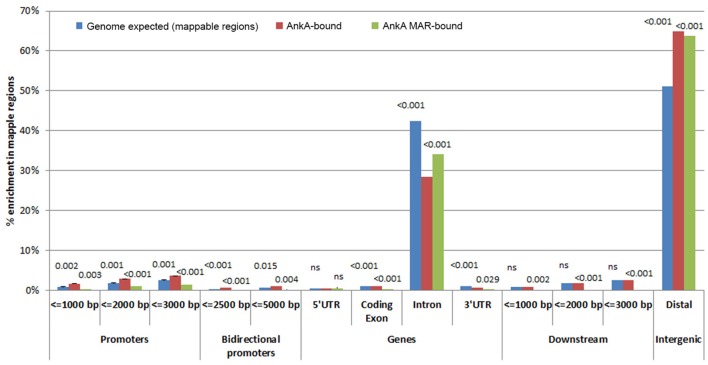
Relative AnkA enrichment compared to mappable regions in the chromosomes [genome background (blue)] for all AnkA-enriched sites (red) and AnkA-MAR-enriched sites (green). Promoter regions are shown as distance upstream of transcriptional start sites, genes are shown as 5′ untranslated regions (UTR), coding exons, introns, and 3′UTRs, downstream regions are shown as the distance from the transcription termination sites, and intergenic regions using CEAS. The height of the bars represents the average of 3 separate experiments using individual donor neutrophils, including error bars. Numbers above the bars represent p-values of the comparisons for genomic background vs. enrichment at all AnkA-binding sites (left number) and vs. enrichment of AnkA-bound MARs (right number); p < 0.0168 were considered significant. Compared to genomic background, AnkA is most significantly enriched in distal intergenic regions, including when bound to MARs. Similarly, but to a much lower degree, AnkA is more significantly bound to the promoter regions ≤ 3000 bp upstream of TSSs, but this does not appear to be associated with specific MARs predicted in these promoters. ns, not significant.